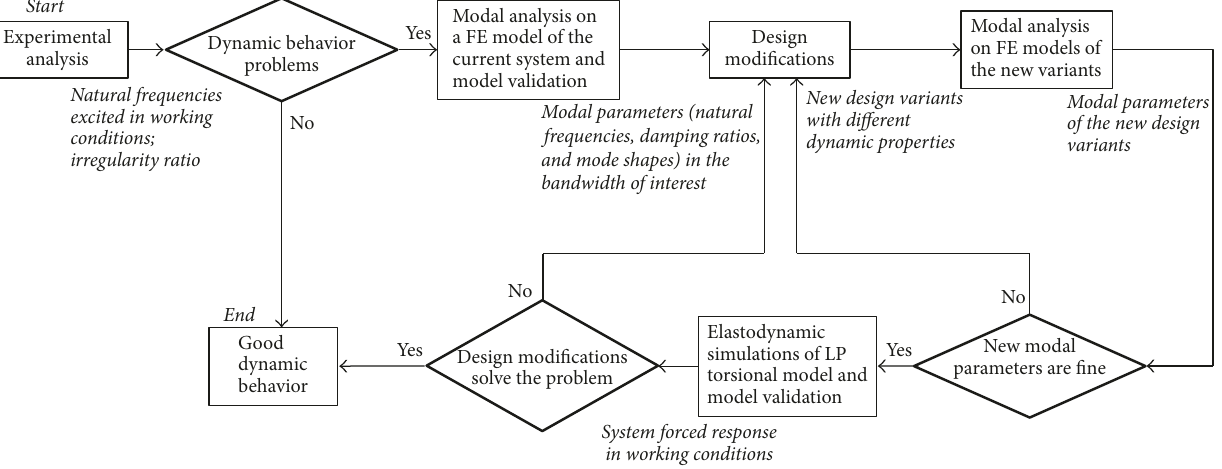
Figure 1: Block diagram of the proposed methodological